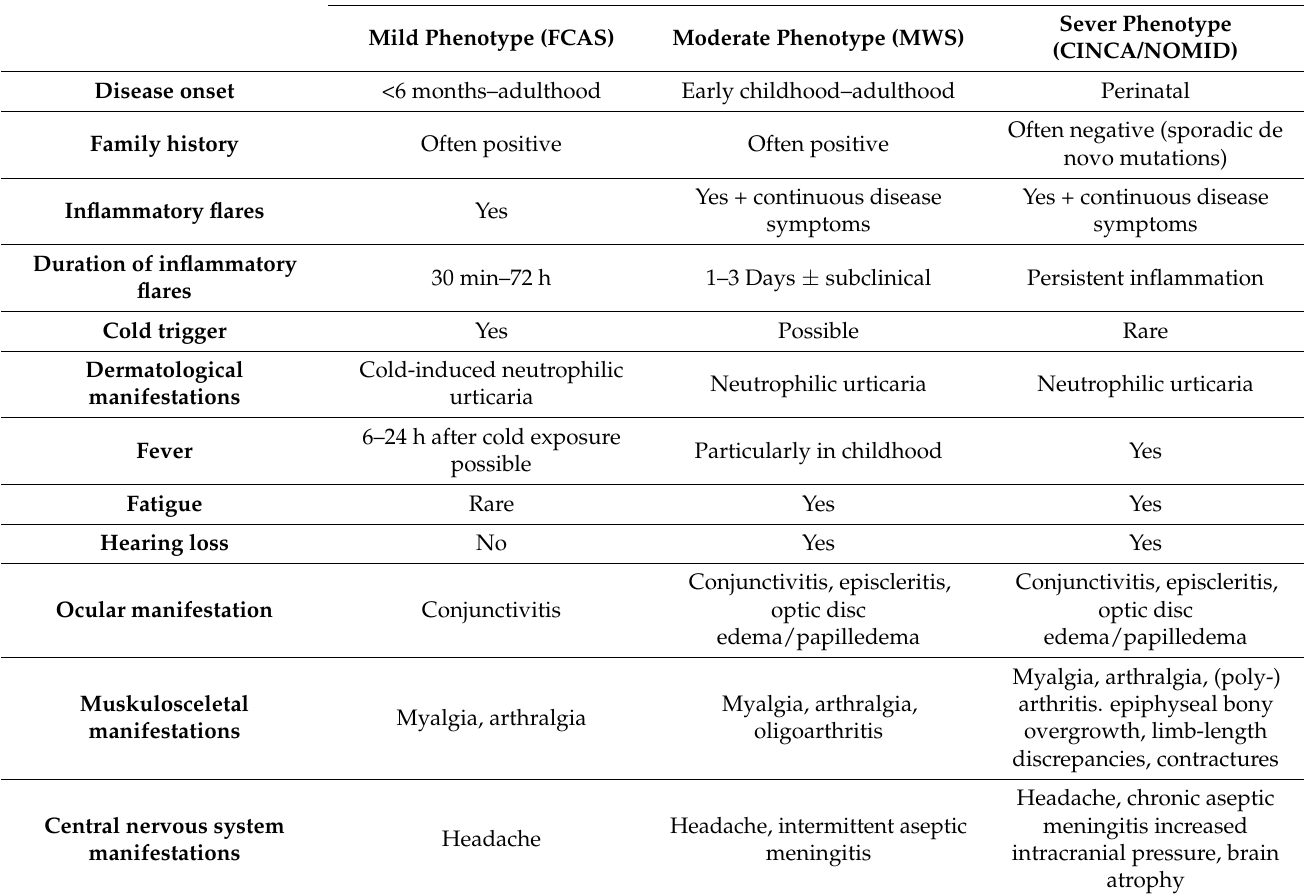
Table 1. Clinical manifestations and characteristics of cryopyrin-associated periodic syndromes (CAPS) (adapted from